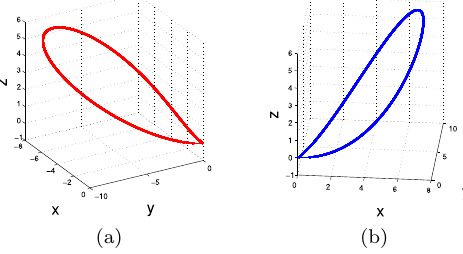
Figure 6. Two homoclinic orbits of system (1.3) to E 0 when a = 2, b = 3, c = 8 . 037 and the different initial values ( x 0 ,y 0 ,z 0 ): (a) ( x 0 ,y 0 ,z 0 ) = ( − 3 . 82 × 1 e − 5 , − 6 . 18 × 1 e − 5 , 0), (b) ( x 0 ,y 0 ,z 0 ) = (3 . 82 × 1 e − 5 , 6 . 18 × 1 e − 5 ,